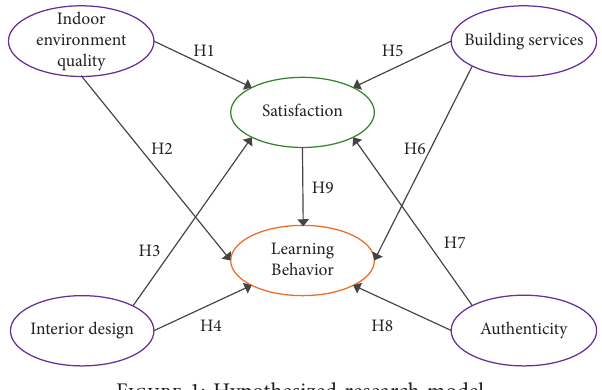
Figure 1: Hypothesized research